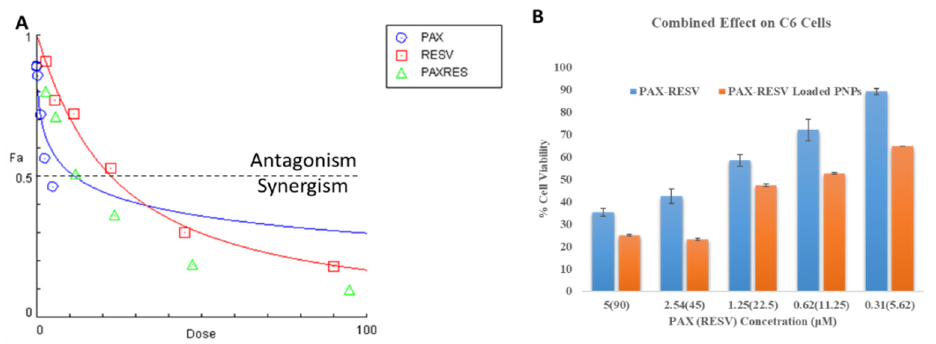
Figure 7. In vitro Cytotoxicity of Combined free PAX/RESV and PAX/RESV PNPs. ( A ) Combined dose effect of free PAX/RESV on C6 cells; ( B ) % Cell Viability of PAX/RESV PNPs on C6 cells.